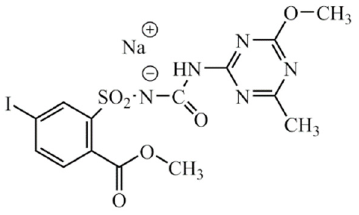
Figure 1. Structure of iodosulfuron-methyl sodium salt.